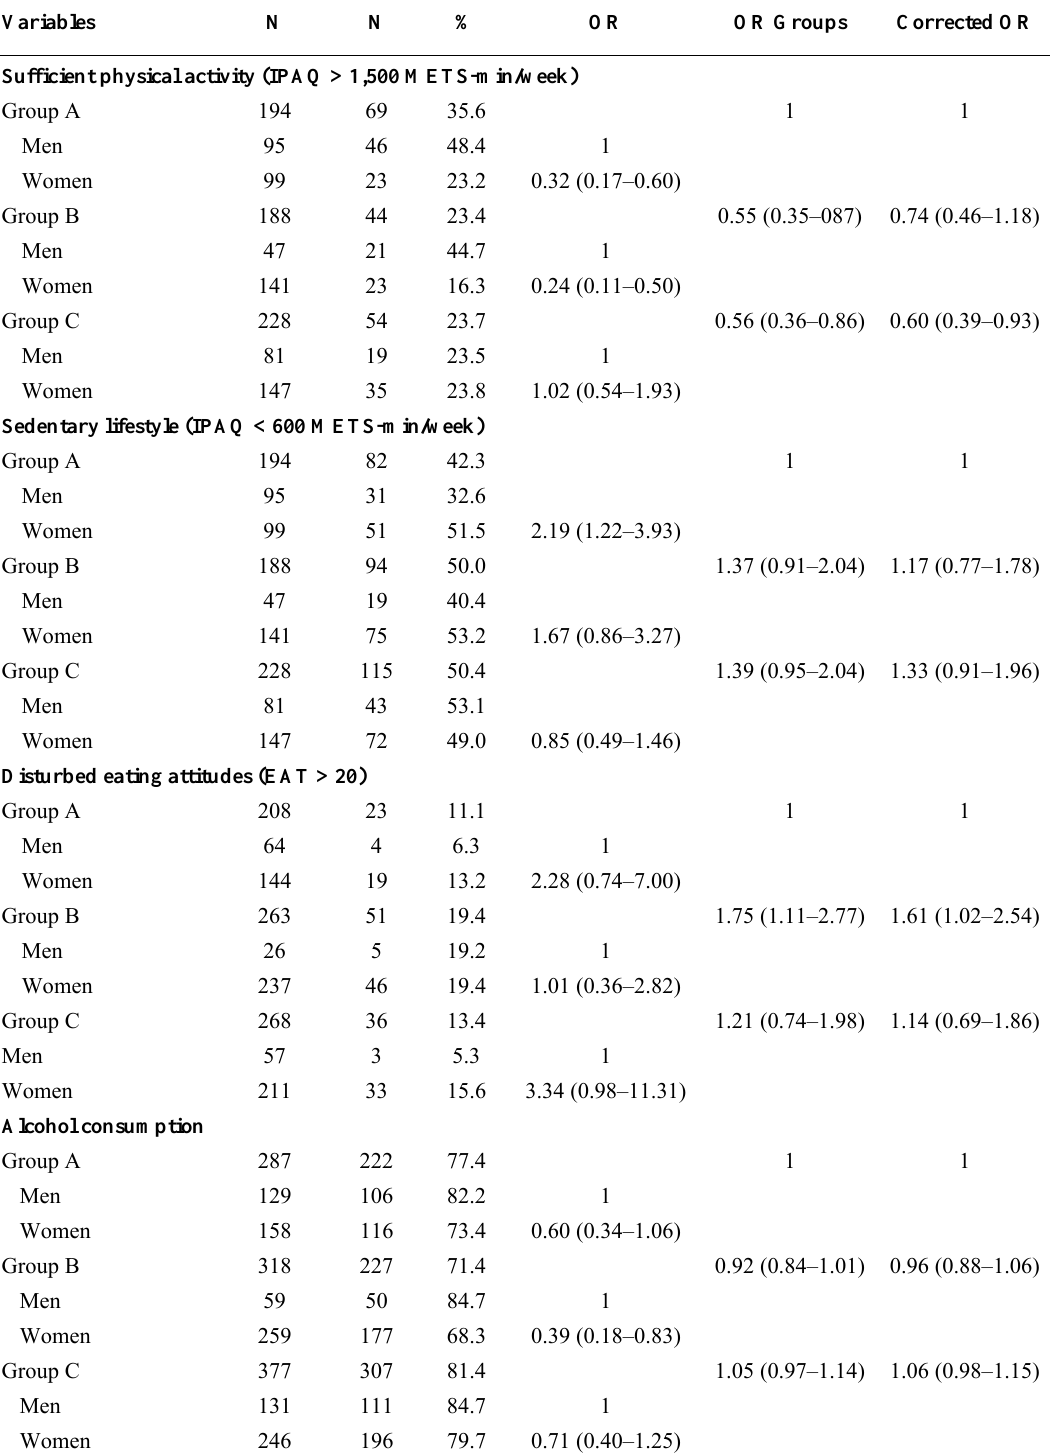
Table 3. Descriptive statistics of health-related behaviours analyzed by student’s degree and OR crude and adjusted for